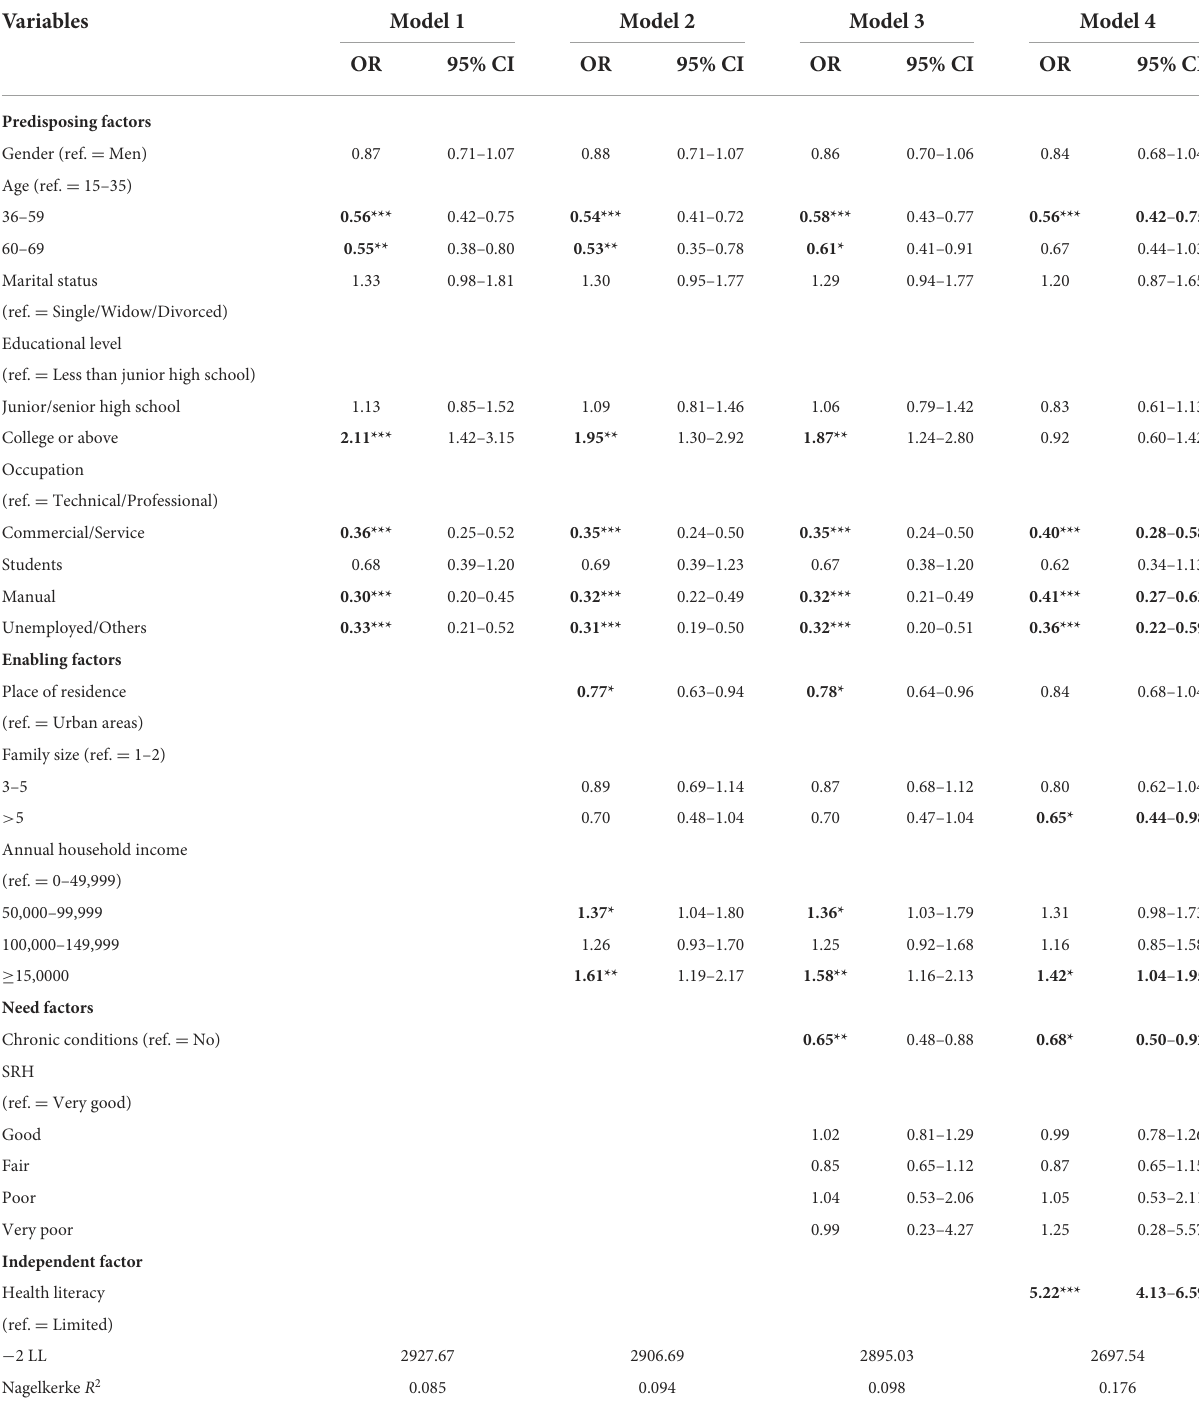
TABLE 3 Logistic regression: factors affecting COVID-19